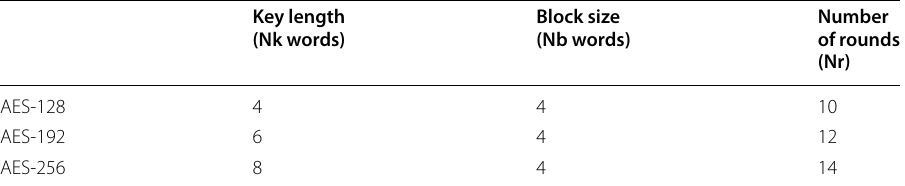
Key length (Nk words)